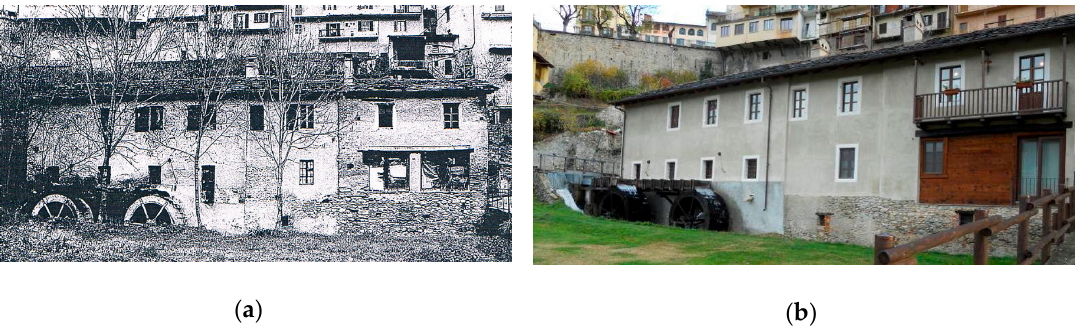
Figure 2. The Riviera mill: ( a ) Before the renovation (2004); ( b ) today.